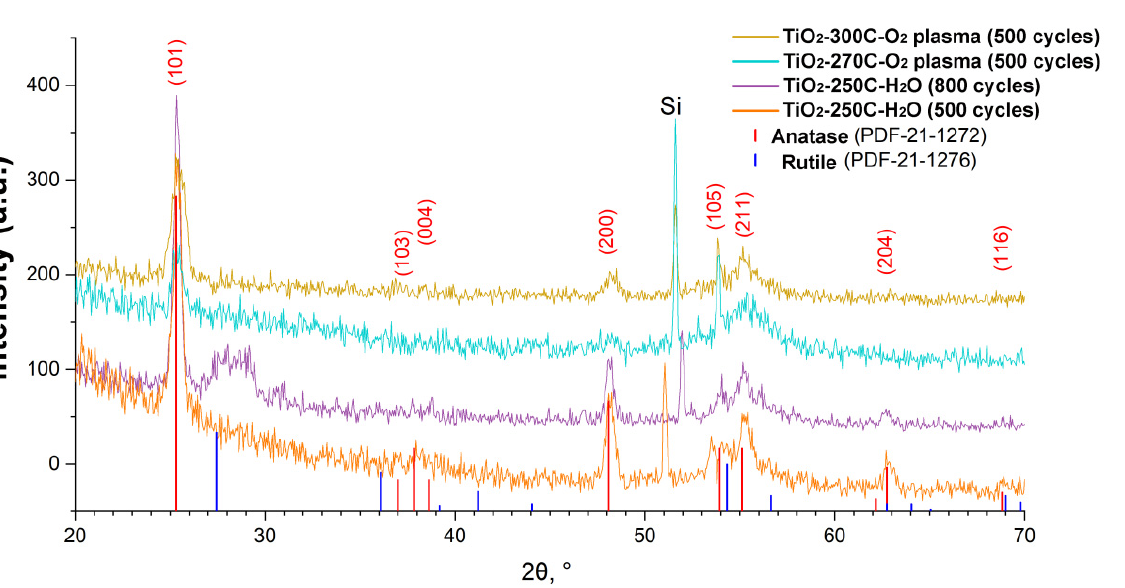
Figure 4. XRD patterns of titanium oxide samples deposited using TTIP on the surface of the silicon.